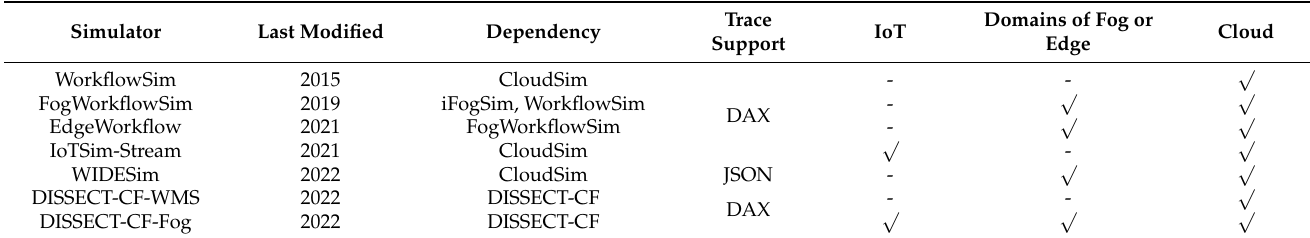
Table 1. Comparison of the related workflow